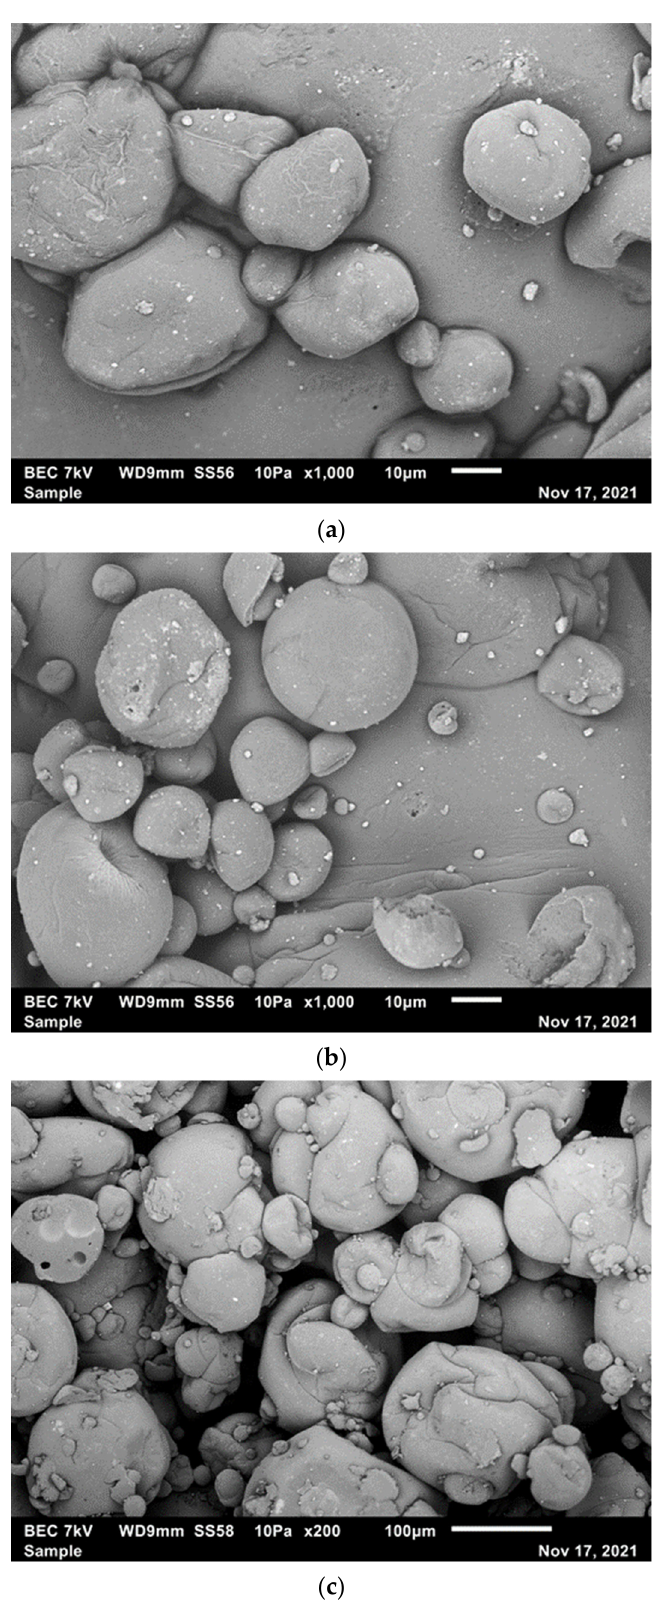
Figure 1. Microcapsules coated with the mixed biopolymer systems of ( a ) bovine casein, yeast β -glucan, and maltodextrin; ( b ) caprine α s1 -I casein, yeast β -glucan, and maltodextrin; and ( c ) caprine α s1 -II casein, yeast β -glucan, and maltodextrin at 0 weeks of storage observed with SEM.